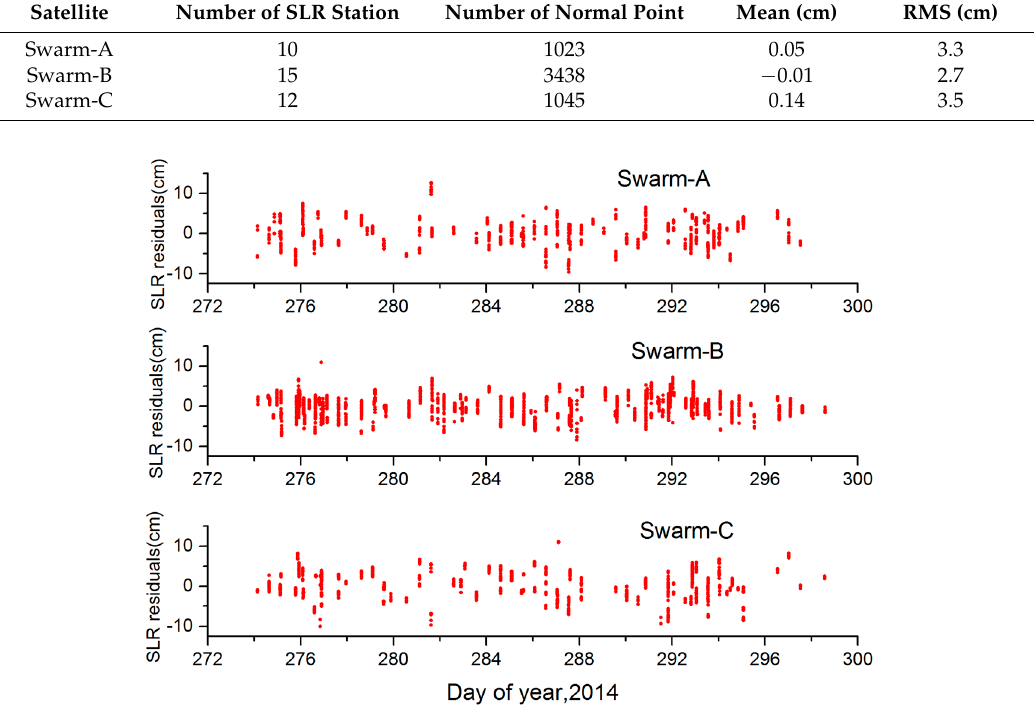
Figure 10. SLR residuals for the Swarm ZD reduced-dynamic POD during DOY 274–298,